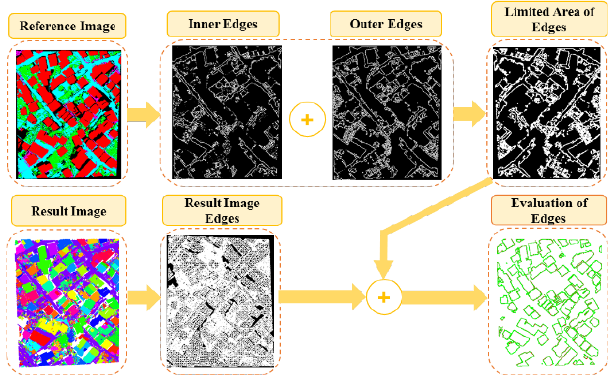
Figure 2 . The general steps of the segmentation evaluation